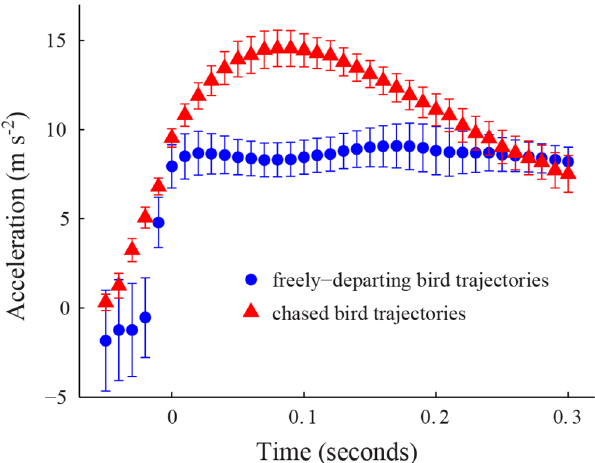
Fig 5. Acceleration in departing trajectories. The red triangle markers show the mean acceleration of the chased bird after departing the feeder (n = 31 trajectories at t c = 0 and n = 30 at 0.29 seconds). The blue circle markers represent the mean acceleration after departure for freely-departing bird trajectories (n = 15). Error bars show the standard error at each time instant. Measurements of the flight speeds of both classes of birds were taken at different times after initial departure and a common timebase t c created with 0 as the instant where the bird first reaches a speed of 0.4 m s -1 .